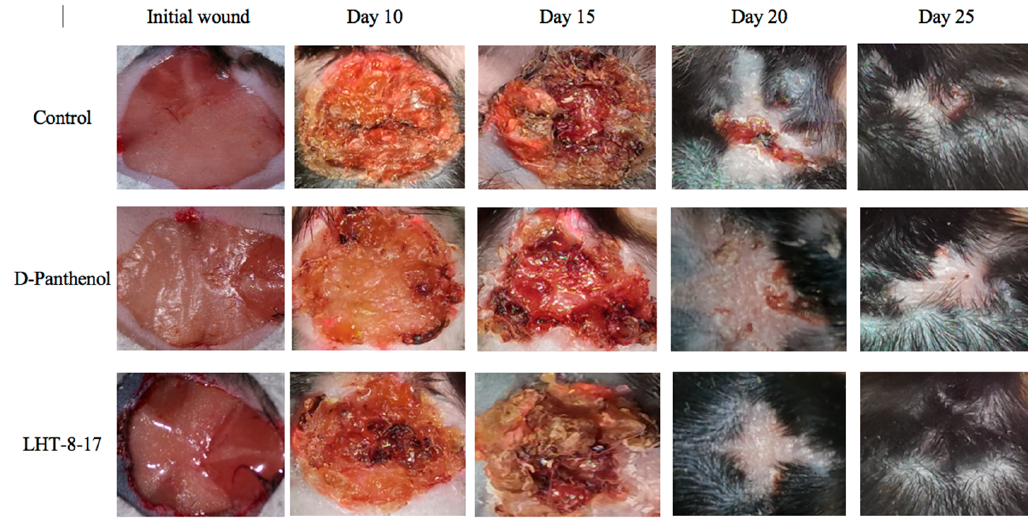
Figure 3. Healing of non-infected planar wounds treated with PBS (control), D-panthenol, and LHT-8-17 for db / db mice treated with T2D.